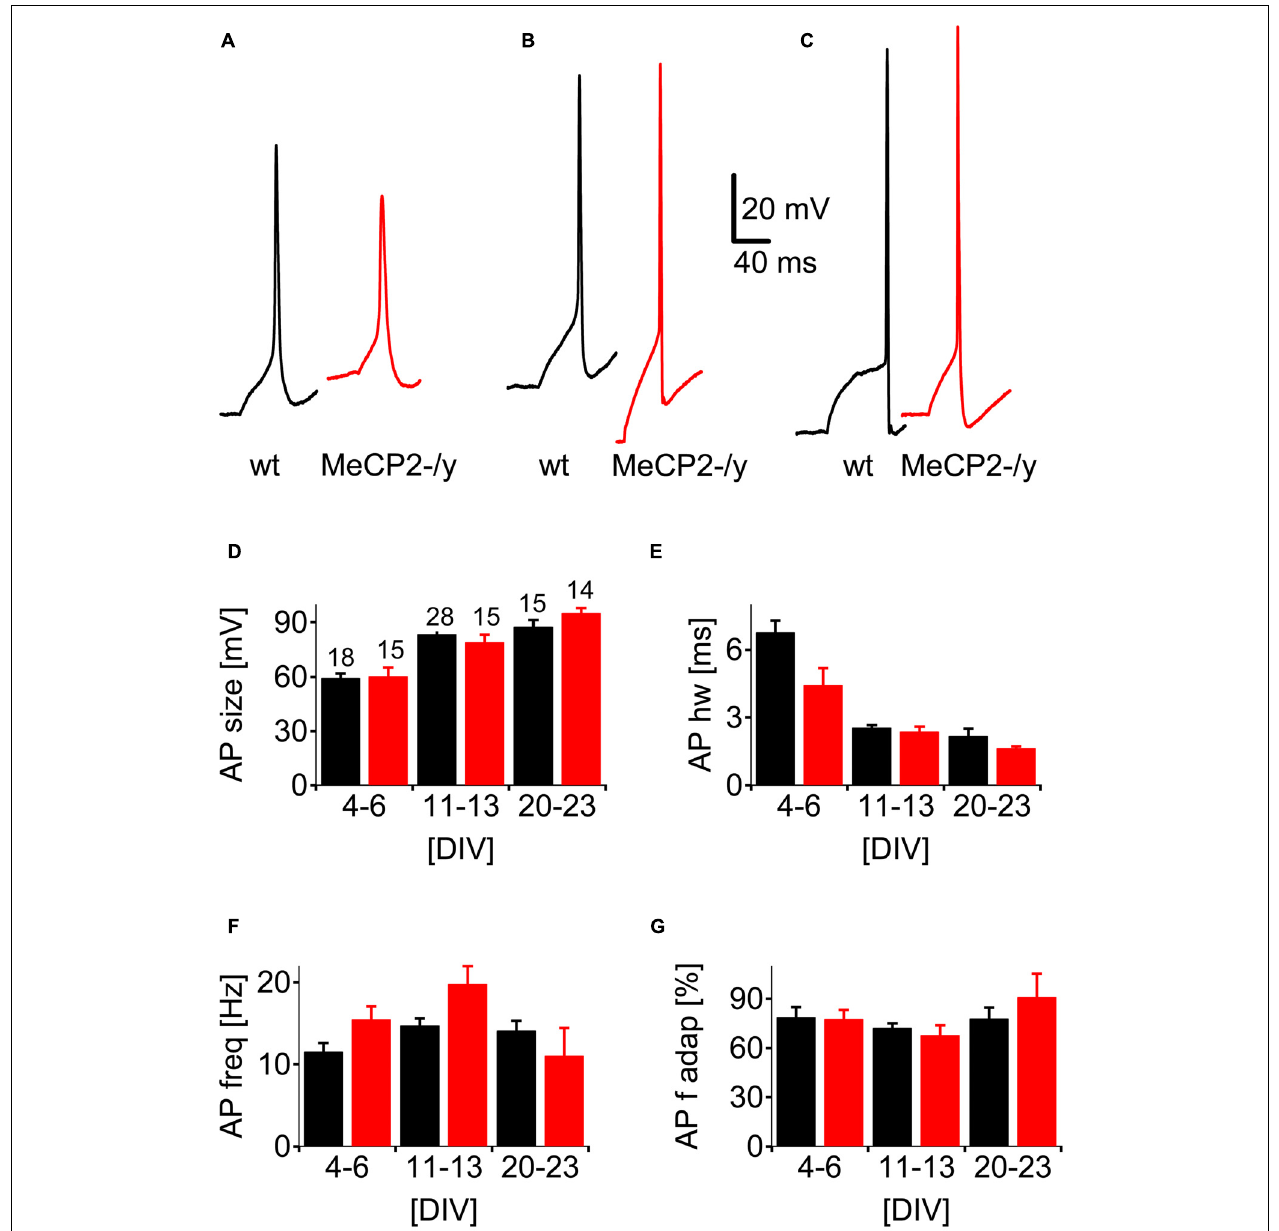
FIGURE 3 | Neuronal spiking patterns as a function of developmental age. Representative single spikes evoked by supra-threshold current injections in cultured neurons at (A) DIV 6, (B) DIV 12, and (C) DIV 21. Repetitive spiking was evoked by current injections shown in Figure 1M . (D–G) Analysis of the spiking